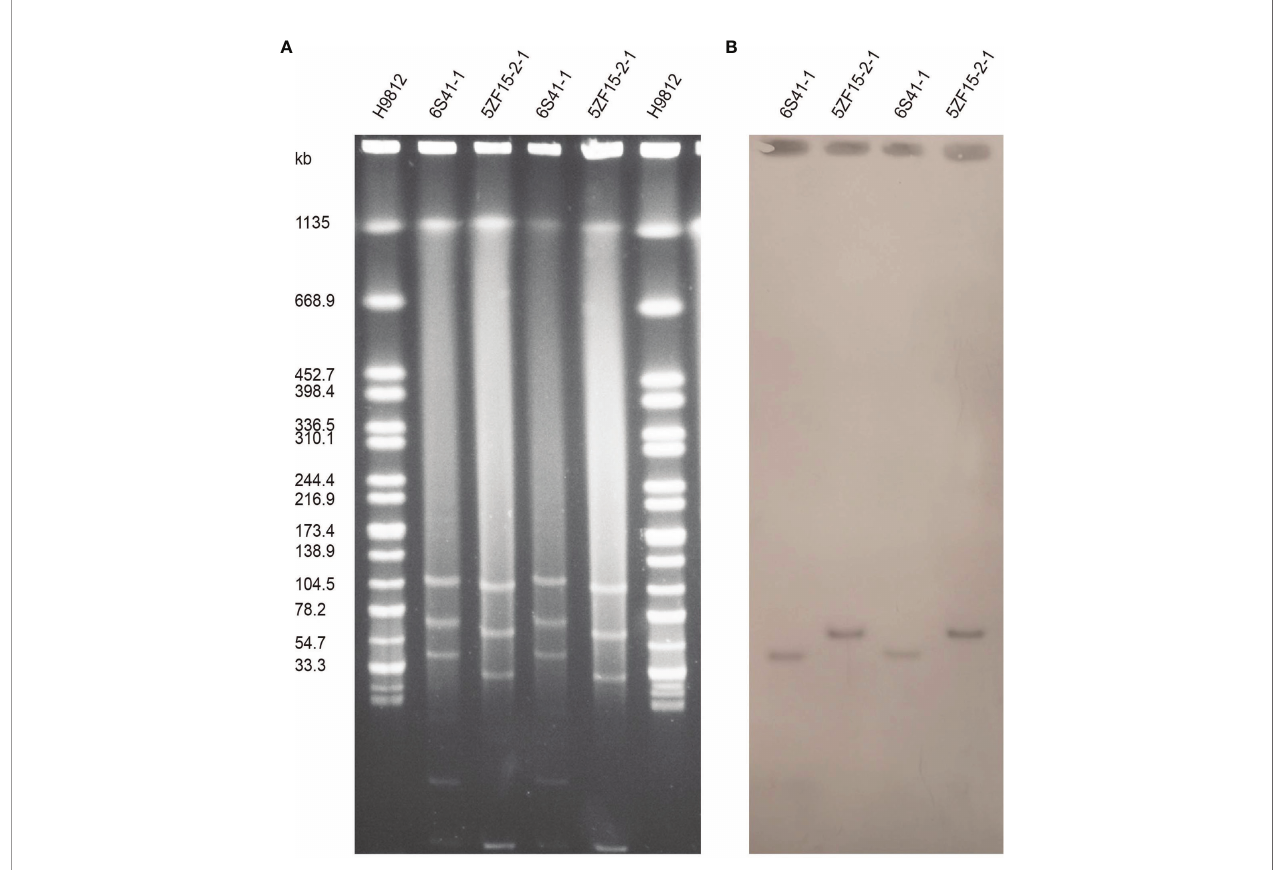
FIGURE 1 | Plasmid pro fi les of E. fergusonii 6S41-1 and 5ZF15-2-1. (A) Plasmid size determination by S1-PFGE, with Salmonella enterica serotype Braenderup H9812 as the size marker. (B) Southern blotting hybridization with an mcr-1 -speci fi c